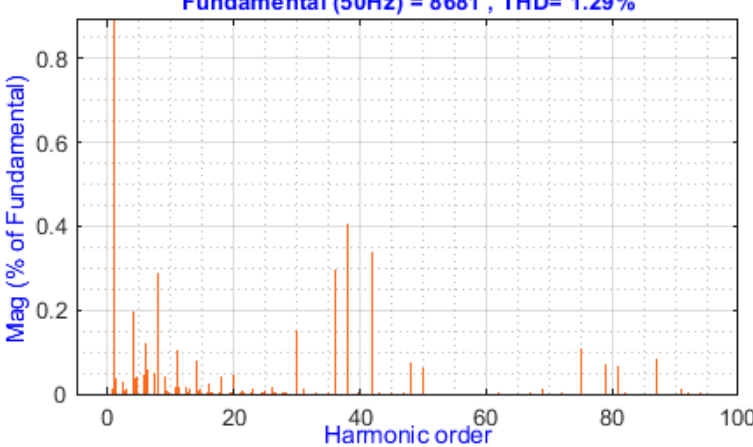
Figure 17. Total and individual harmonics level of the output voltage at PCC after filtering with low